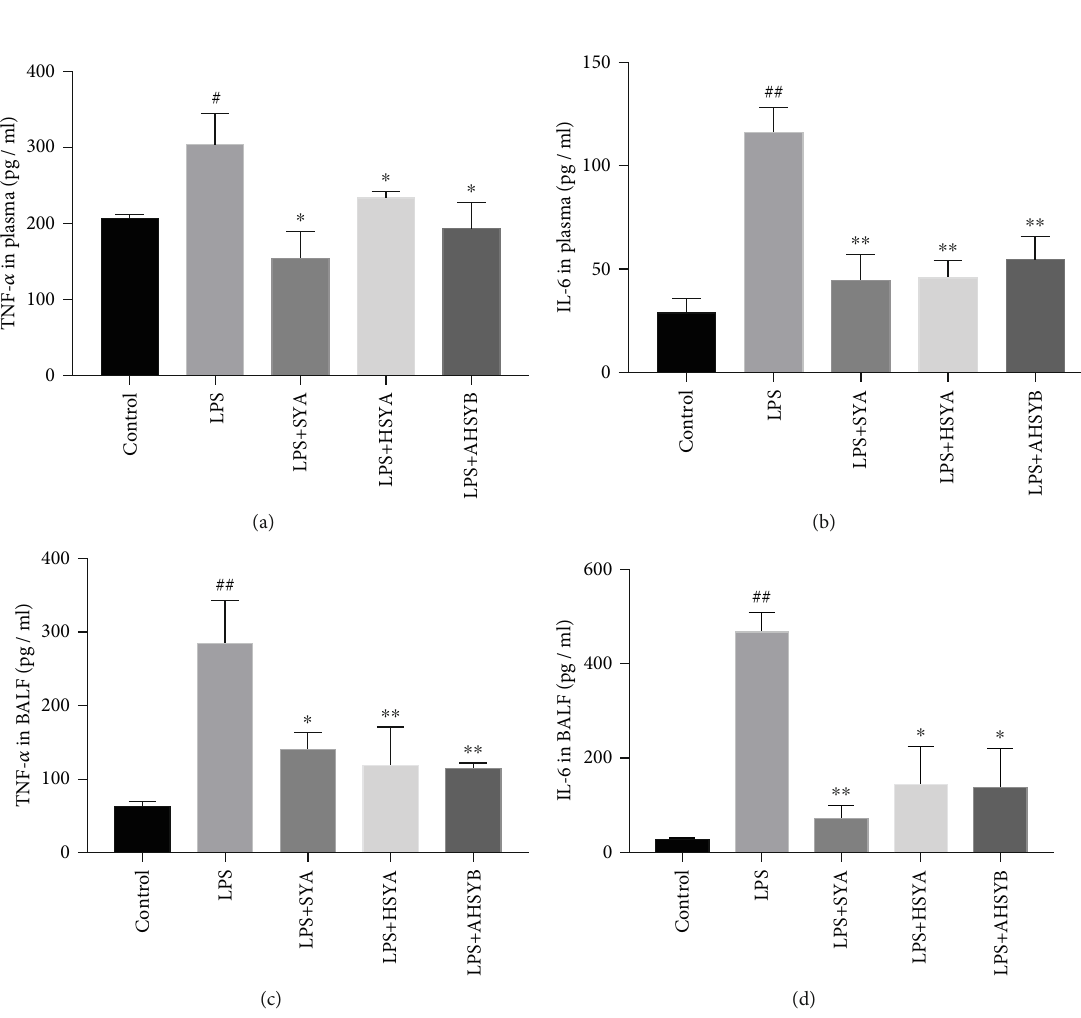
Figure 2: E ff ects of SYA, HSYA, and AHSYB on the production of in fl ammatory cytokines in LPS-induced ALI. (a) TNF- α in plasma 24h after ALI. (b) IL-6 in plasma 24 h after ALI. (c) TNF- α in BALF 24 h after ALI. (d) IF-6 in BALF 24 h after ALI. The values presented are mean ± SEM , ## P < 0 : 01 vs the control group; # P < 0 : 05 vs the control group; ∗ P < 0 : 05 vs the LPS group; ∗∗ P < 0 : 01 vs the LPS